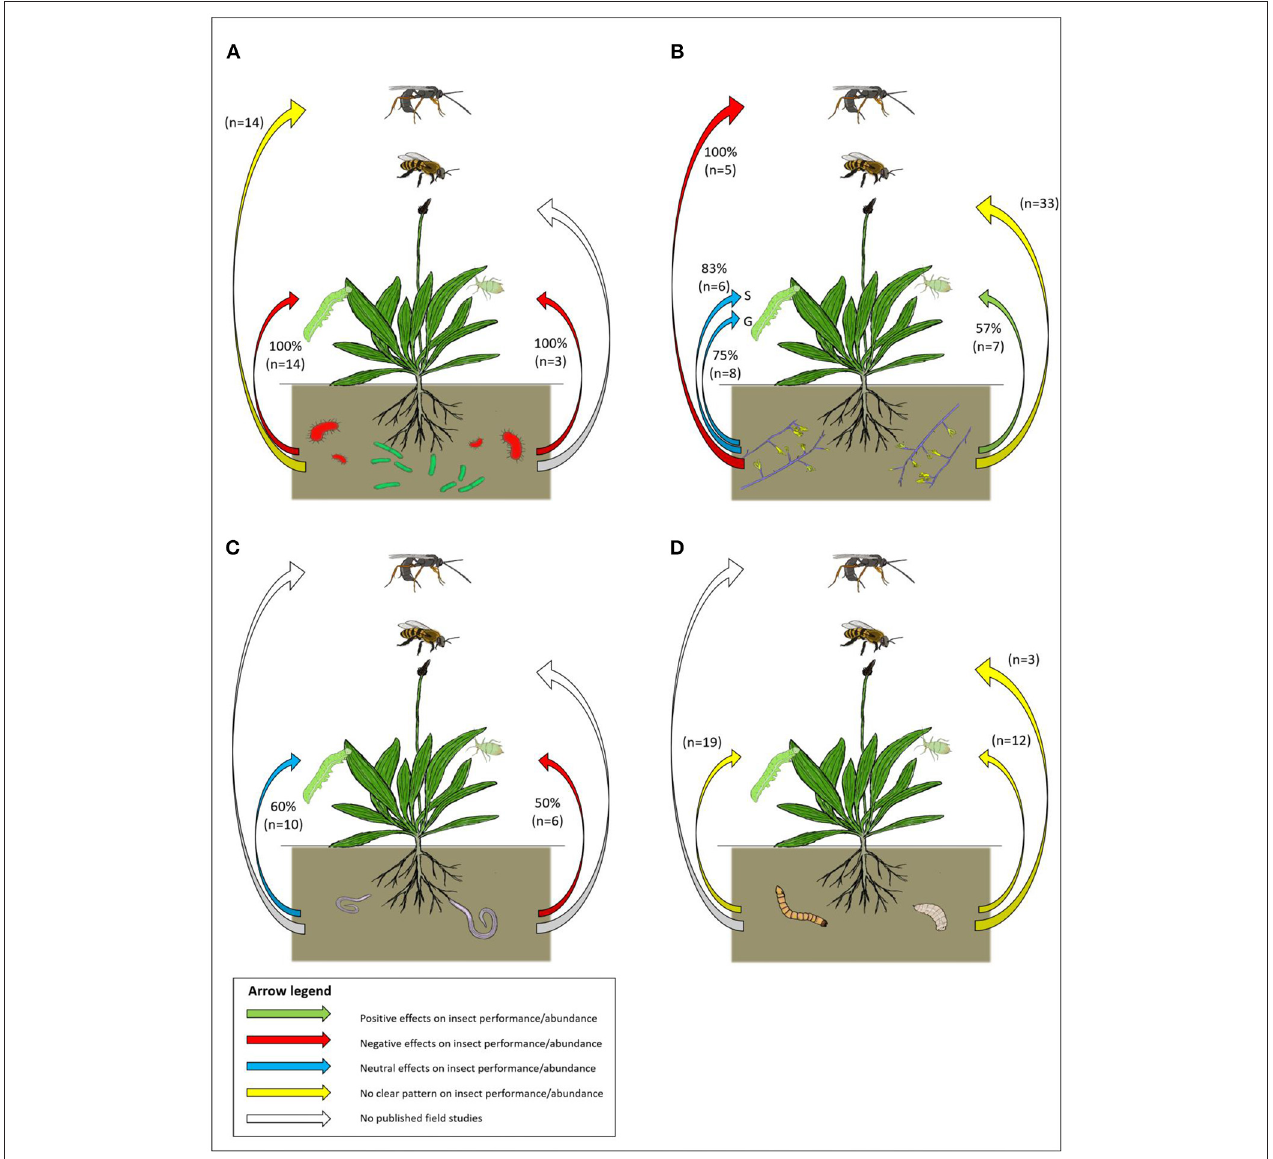
FIGURE 2 | A schematic overview of the effects of (A) plant growth-promoting bacteria, (B) arbuscular mycorrhizal fungi, (C) plant-parasitic nematodes and (D) soil arthropods on the most frequently reported aboveground plant-insect interactions (interactions between plants and chewing and sap sucking herbivores, pollinators and natural enemies, respectively). In (B) S, Specialist; G, Generalist. Arrows indicate plant-mediated effects of soil organisms on aboveground insects. Green arrows represent generally positive indirect effects on aboveground insects, red arrows represent generally negative indirect effects on aboveground insects, blue arrows represent generally neutral effects on aboveground insects. Yellow arrows indicate that effects are observed, but no clear patterns emerged and white arrows indicate that interactions have not been reported in literature. Percentages with the green, red and blue arrows represent the percentage of the total reported interactions that followed the pattern (sample size between